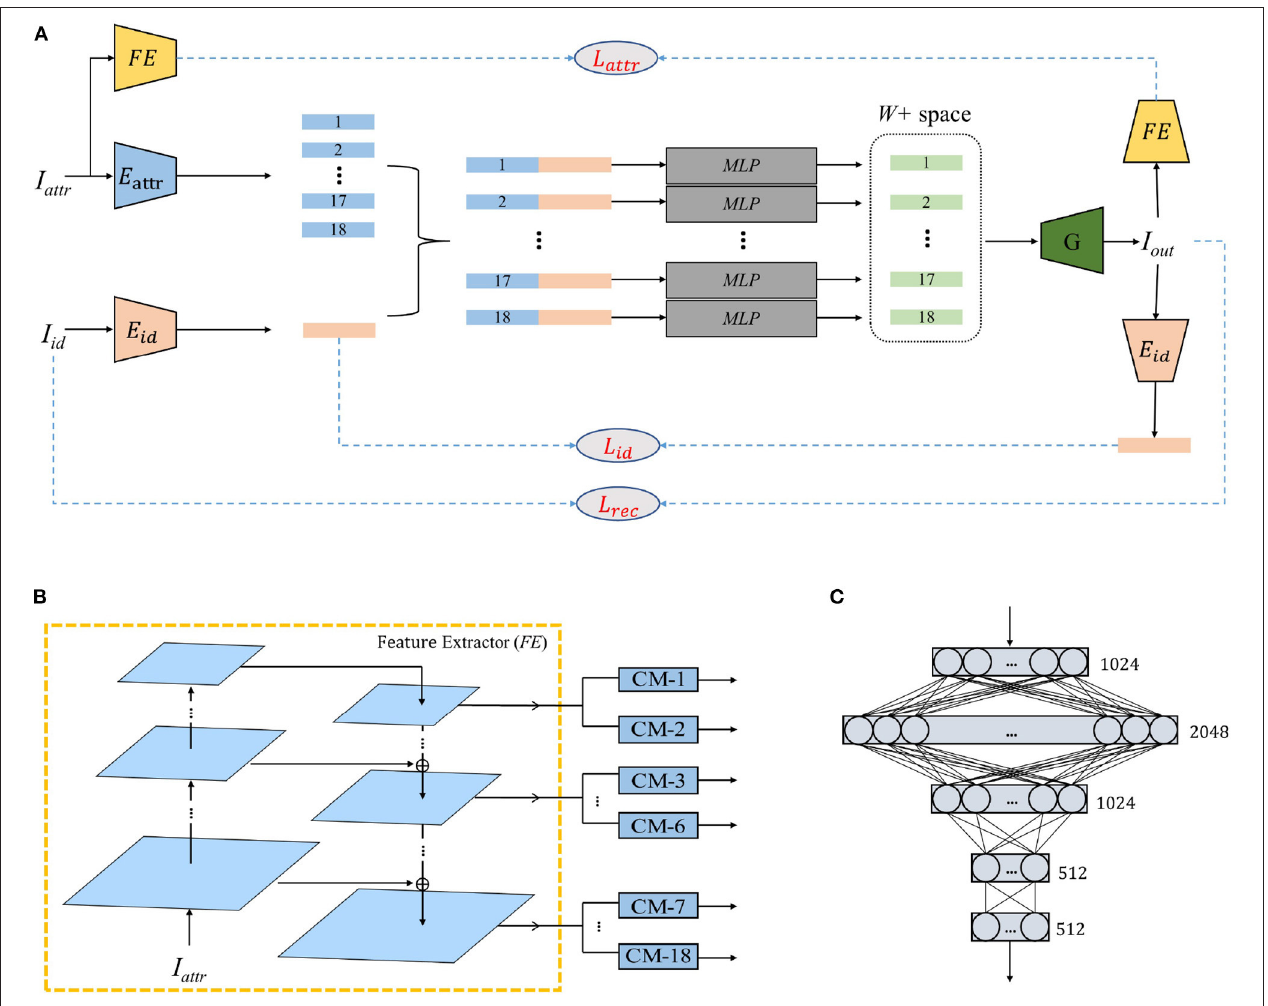
FIGURE 2 | The overall structure and data flow of the proposed model. (A) is the flow of our method. (B) is the structure of E attr . (C) is the structure of Multilayer Perceptron